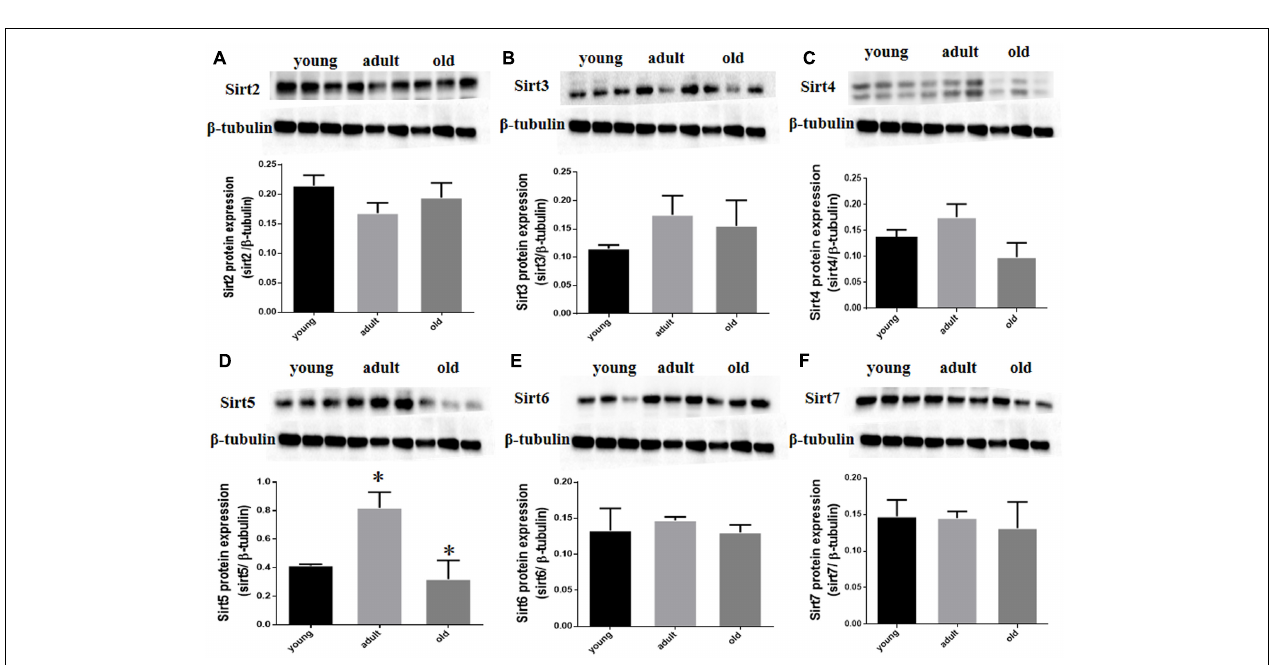
FIGURE 5 | Protein levels of SIRT1 in aging and injured rat retinas. Representative Western blot showing SIRT1 protein levels in aged (old) retinas compared to young and adult retinas (A) . SIRT1 protein levels in rat retinas following transient retinal ischemia-reperfusion injury (B) . Densitometry analysis of SIRT1 in aged and injured retinas and normalized to β -tubulin is shown below the representative blots ( ∗ P < 0.05, n = 4).